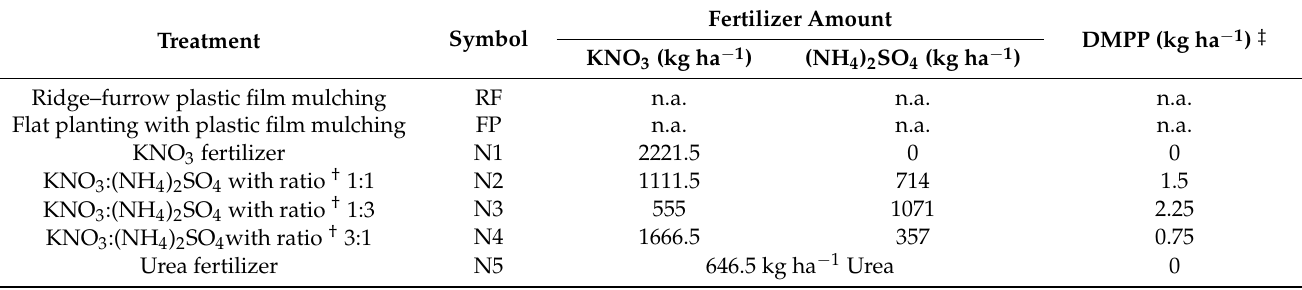
Table 2. Details of the